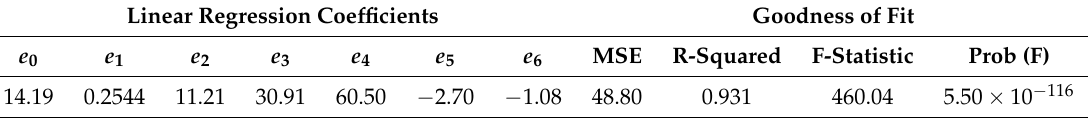
Figure 15. Speed data grouped by traffic conditions and predictions using the linear mode with all explanatory variables. Table 10. Model coefficients and goodness of fit metrics for the speed vs. all other variables